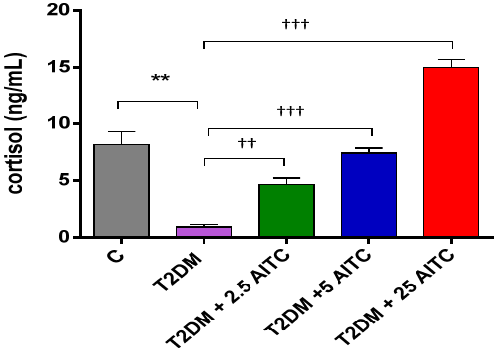
Figure 3. Effects of AITC on cortisol levels in the blood serum of diabetic rats.Each column represents the mean ± SEM ( n = 8). ** p ≤ 0.01 compared with C group; †† p ≤ 0.01, ††† p ≤ 0.001 compared